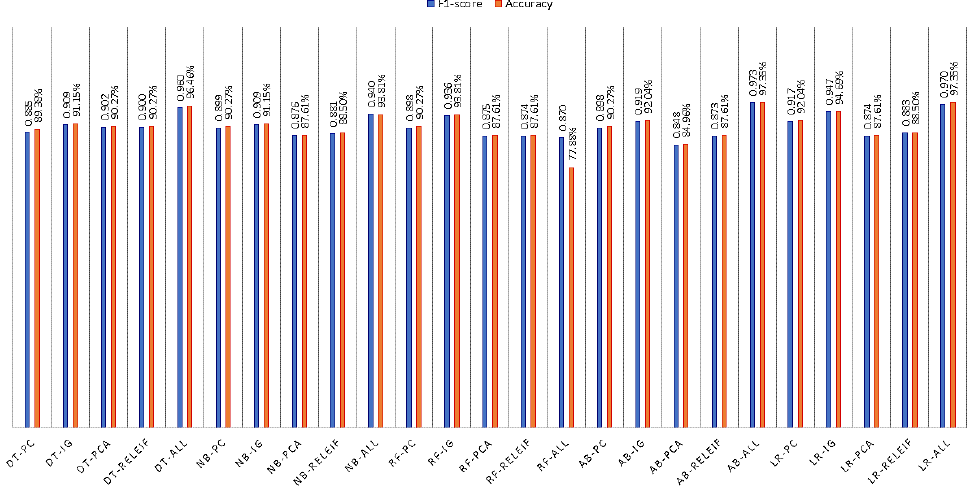
Figure 4. F1-score and Accuracy values of DT, NB, RF, AB and LR with 80%–20% split and five FS method.